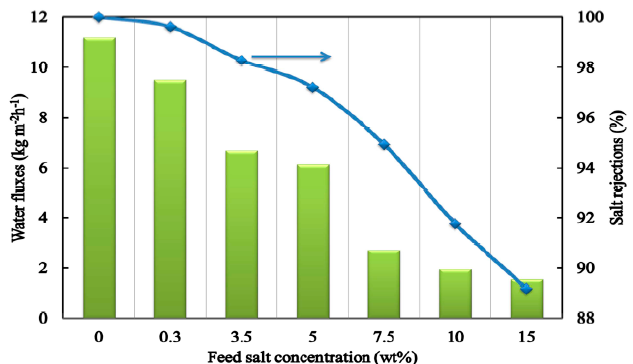
Figure 9. Water fluxes and salt rejections of the silica-based membrane performance as a function of salt concentration at 22 °C [175]. Reproduced with permission from [175].